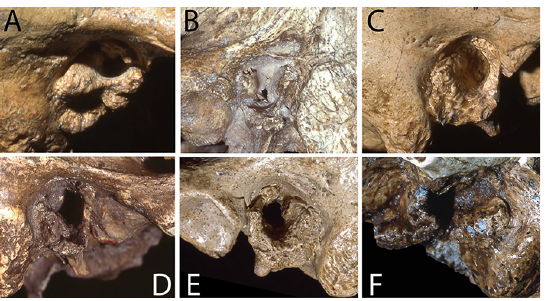
Fig 4. Examples of external auditory exostoses (EAE) among Neandertal specimens. A: Shanidar 1 right (grade 3); B: La Chapelle-aux-Saints 1 left (grade 2); C: Krapina 3 right (grade 1); D: Spy 1 right (grade 2); Krapina 39.1 left (grade 2); Tabun 1 left (grade 2). Not to scale. Photos: A, B, C, E and F: E. Trinkaus; D: H.